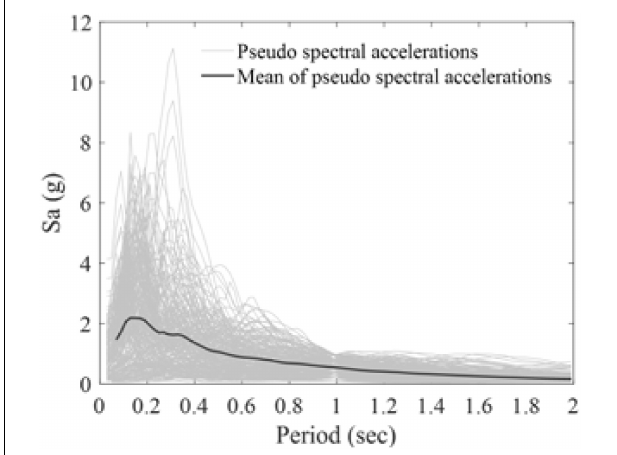
FIGURE 10 | Pseudospectral acceleration for the 232 records from subduction.